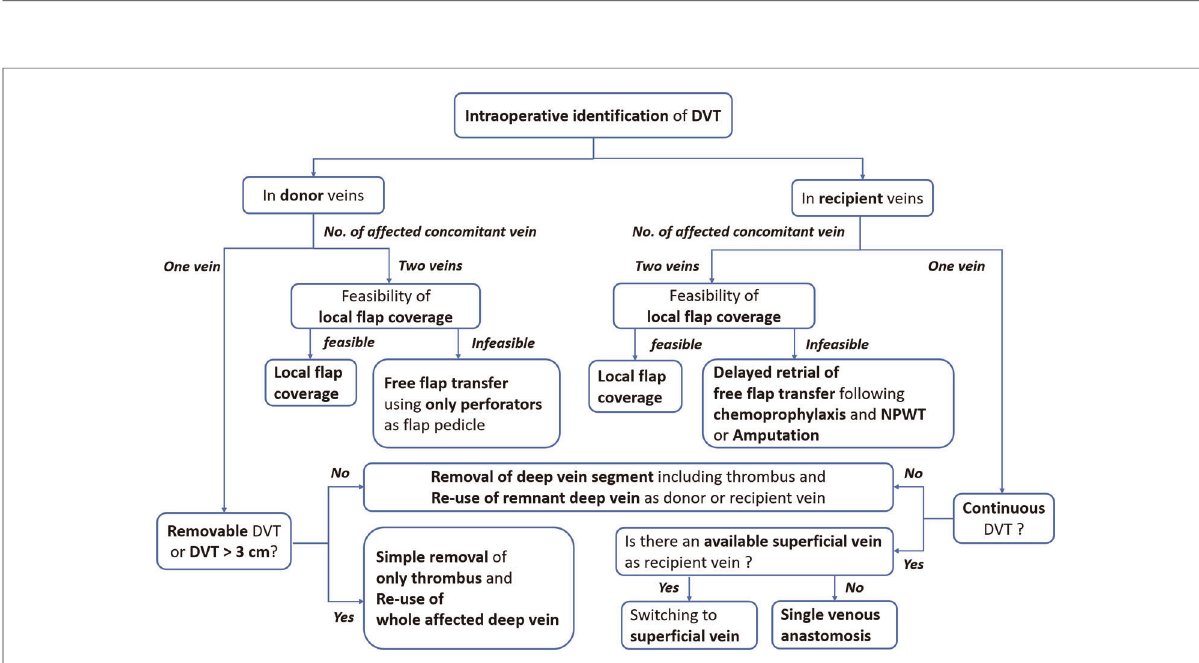
FIGURE 6 An algorithm for dealing with DVT in donor or recipient veins encountered during a free anterolateral thigh perforator fl ap transfer. DVT, deep vein thrombosis; NO., number; NPWT, negative pressure wound